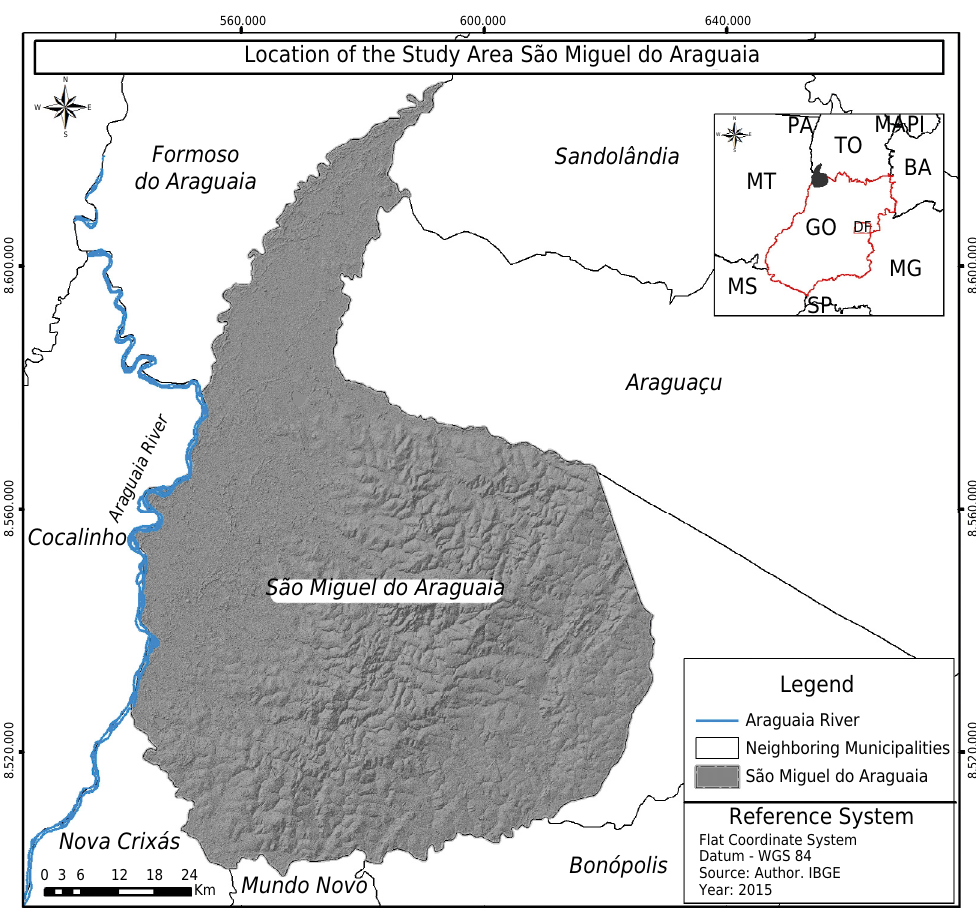
Figure 1. Location of the municipality of São Miguel do Araguaia, state of Goiás,